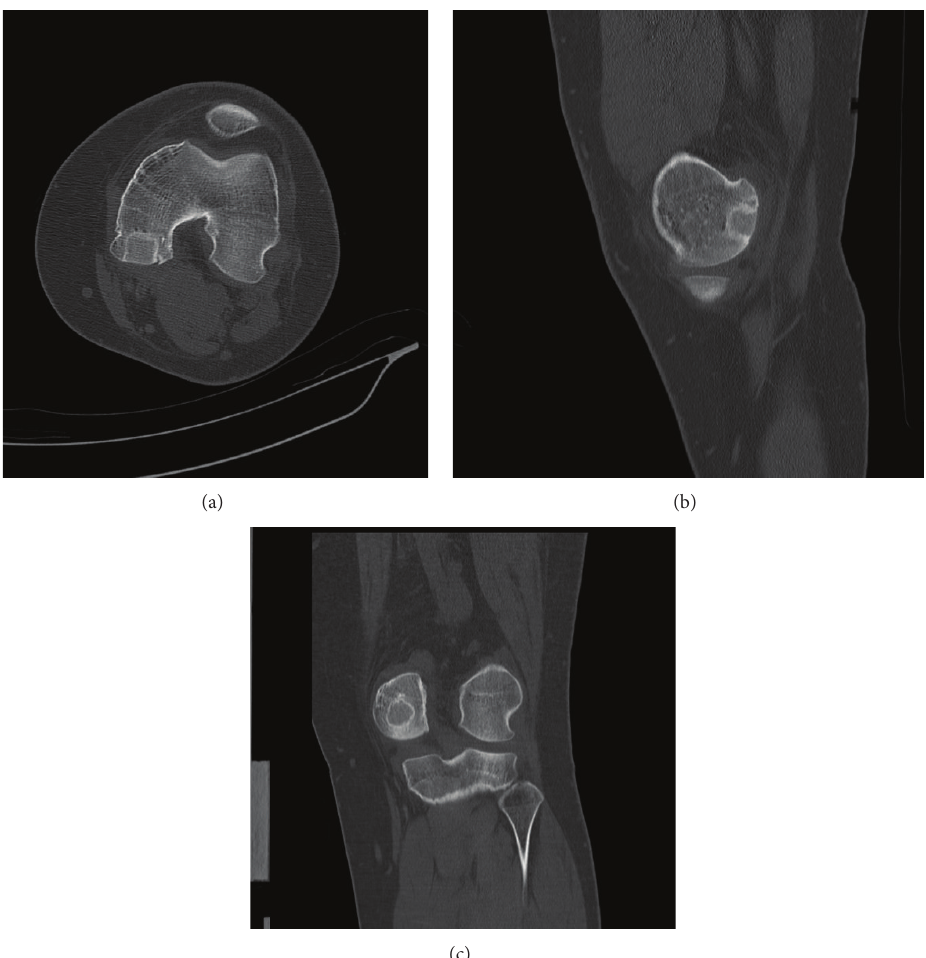
Figure 8: One-year postoperative axial (a), sagittal (b), and coronal (c) CT scan demonstrating osteochondral allograft incorporation and congruency of chondral surface. No evidence of local